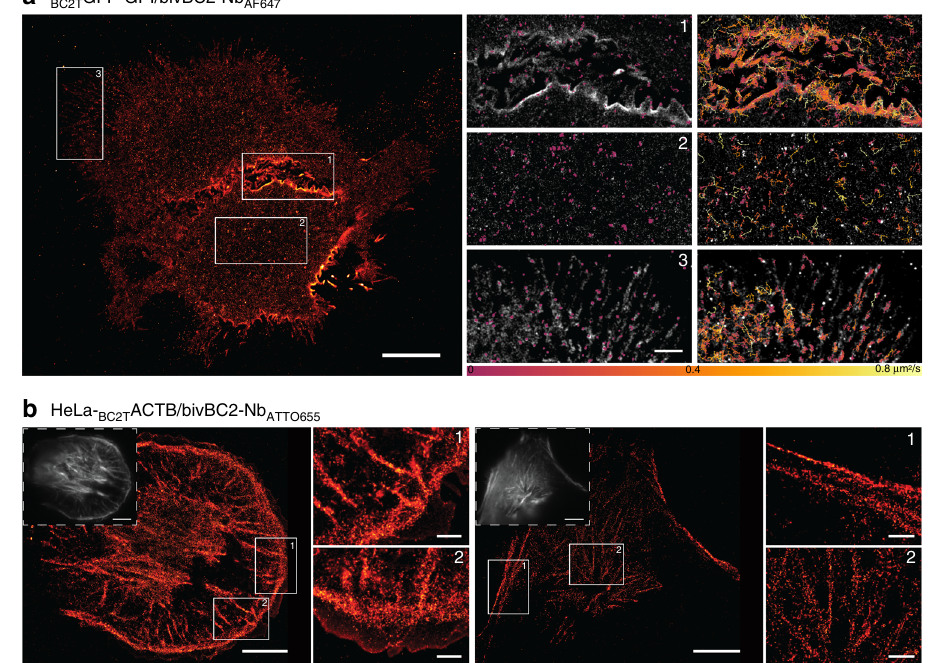
Fig. 5 Super-resolution imaging and single-particle tracking in live HeLa cells. a dSTORM image of live BC2T GFP-GPI expressing HeLa cells stained with bivBC2-Nb AF647 and insets in gray scale overlaid with single-particle trajectories of immobile (diffusion coef fi cient below 0.02 µ m 2 s − 1 , left) and mobile (diffusion coef fi cient above 0.02 µ m 2 s − 1 , right). Color scale of diffusion coef fi cients is given under insets. Scale bars 10 µ m in images, 2 µ m in insets. Supplementary Movies 1 – 4 show the recorded live BC2T GFP-GPI dynamics of the whole cell and the corresponding insets. b Live-cell dSTORM images of two HeLa- BC2T ACTB cells stained with bivBC2-Nb ATTO655 . Wide- fi eld fl uorescence images in upper left corners. Scale bars in 10 µ m, 2 µ m in insets.